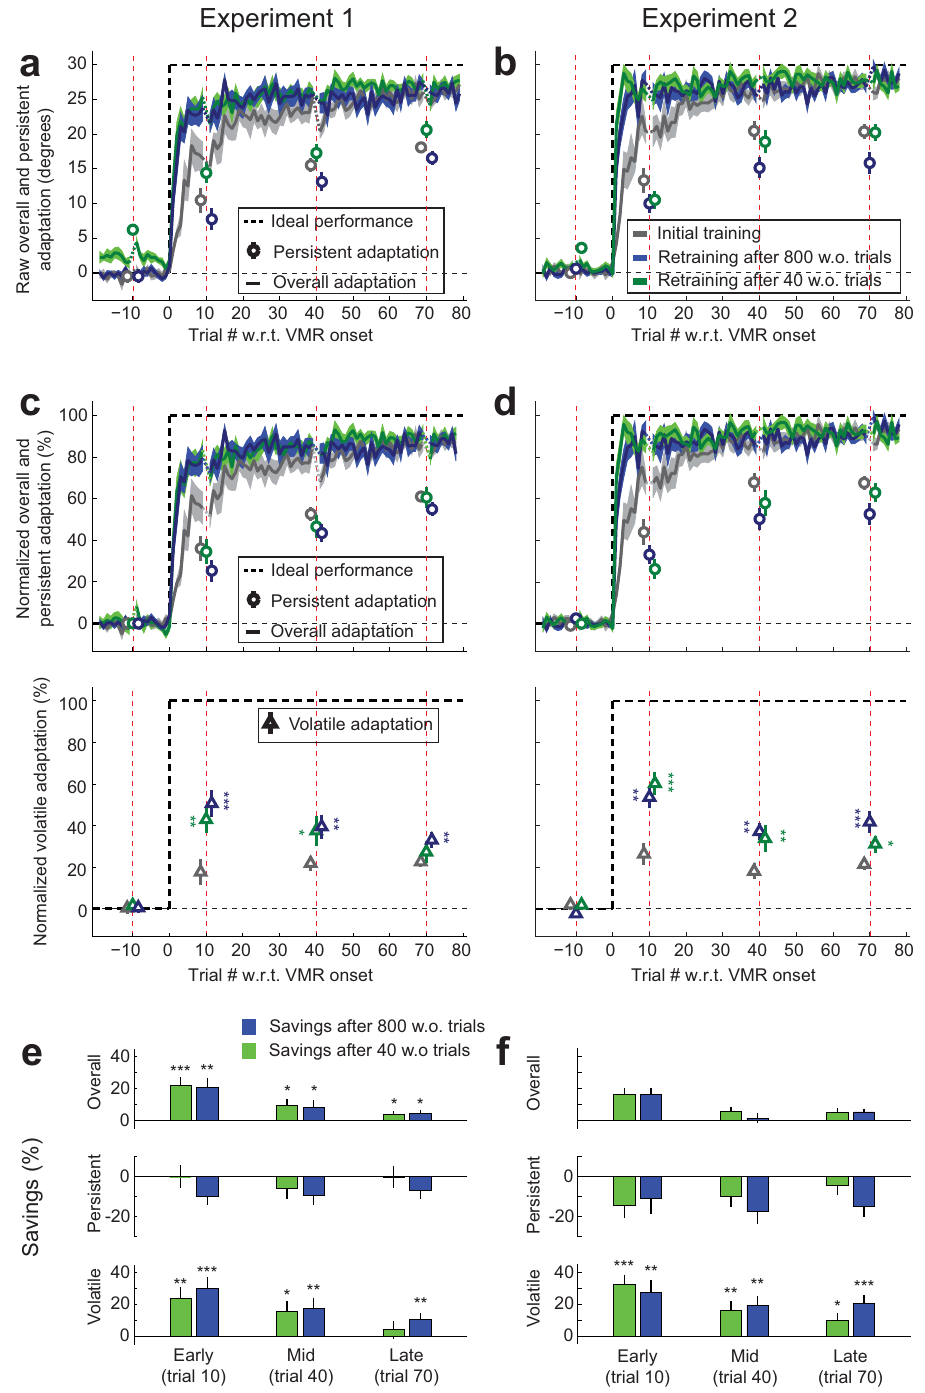
Fig 3. Temporally-volatile adaptation displays savings, but temporally-persistent adaptation does not. (a, b) Learning curves for Experiments 1 and 2, showing overall and persistent adaptation (solid lines and circles, respectively). Persistent adaptation during training or retraining was assessed after a 60-s delay as shown in Fig 1. The dashed black line indicates ideal performance and error bars indicate SEM. Overall adaptation (solid lines) is faster for retraining after both a 40-trial washout period (green) and an 800-trial washout period (blue) when compared to initial adaptation (gray). In contrast, persistent adaptation (circles) is not faster during retraining than initial training. Note that performance during the retraining period following a 40-trial washout (green) can be inflated because